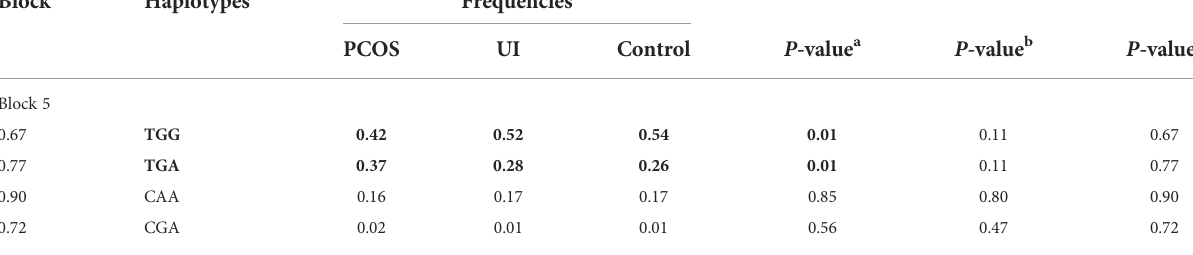
TABLE 4 Haplotype analysis between women with and without